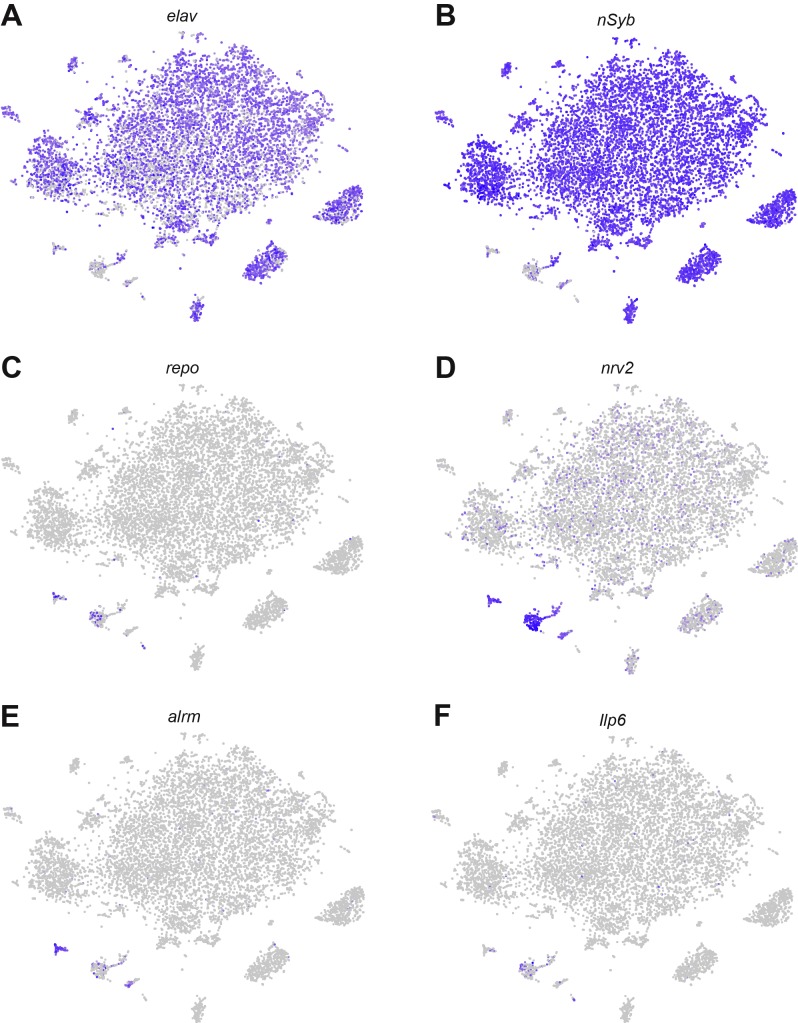
Expression levels of glia-specific genes and Ilp 6.(A–B) tSNE plots showing the expression levels of the neuronal markers embryonic lethal abnormal vision (elav) and neuronal synaptobrevin (nSyb). (C–E) tSNE plots showing the expression levels of the glial markers reversed polarity (repo) and nervana 2 (nrv2), and the astrocyte marker astrocytic leucine-rich repeat molecule (alrm) (Doherty et al., 2009). (F) tSNE plots showing the expression levels of Insulin-like peptide 6 (Ilp6), confirming its expression in glia.